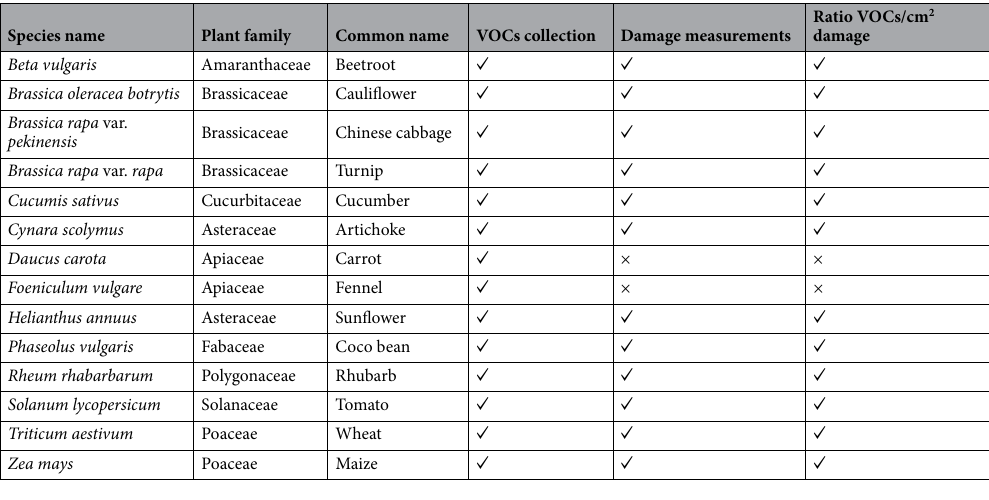
Table 1. List of the plant species used in the study. Check marks ( ✓ ) show the different collections/measures (VOCs collection, damage measurements, and calculation ratio VOCs/cm 2 damage) that were performed with each